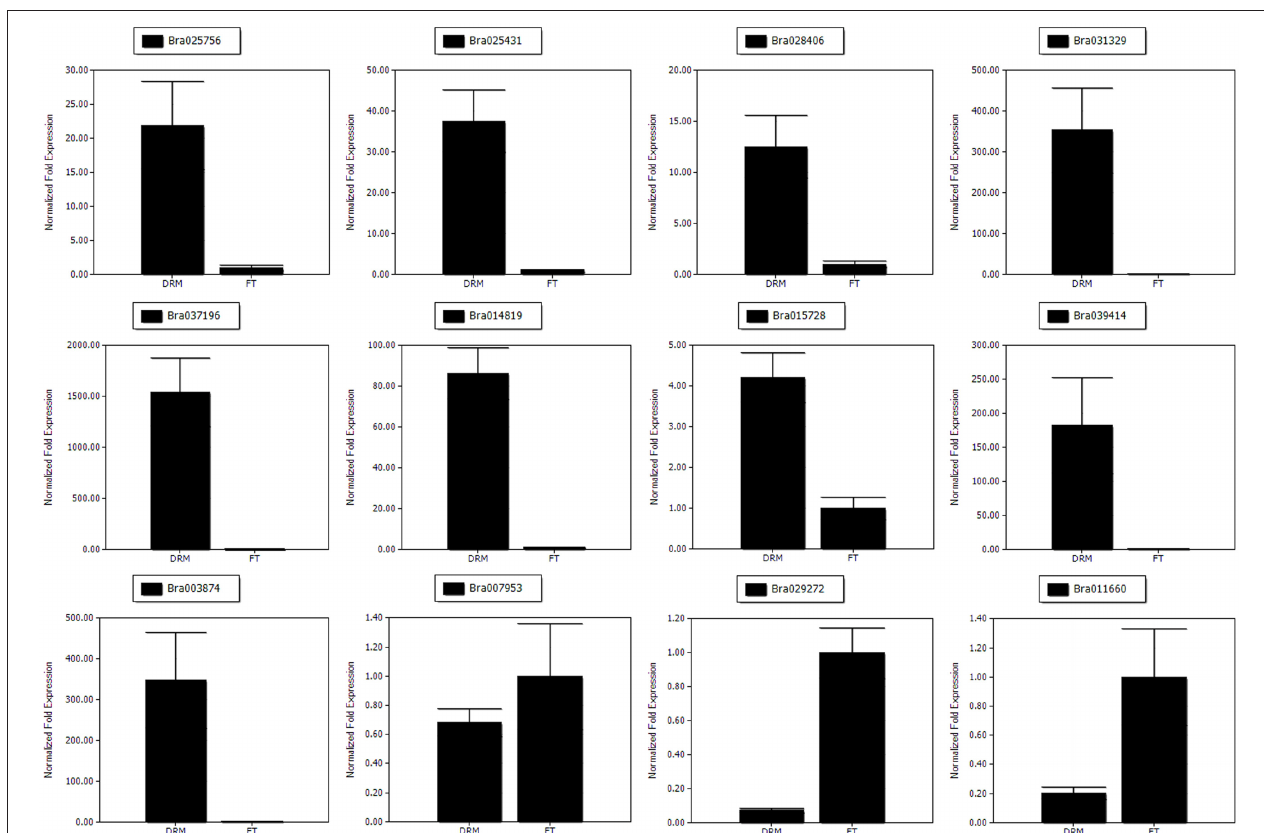
FIGURE 7 | The qRT-PCR analysis of gene expression patterns. The relative expression levels for 12 DEGs are shown.